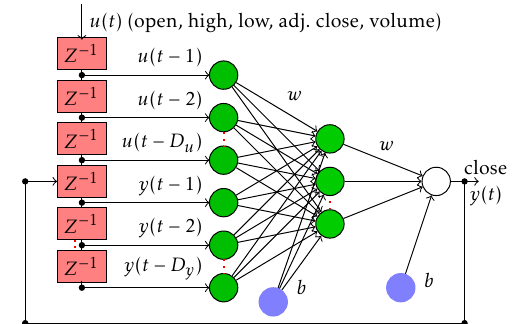
Table 1. NARX parameter